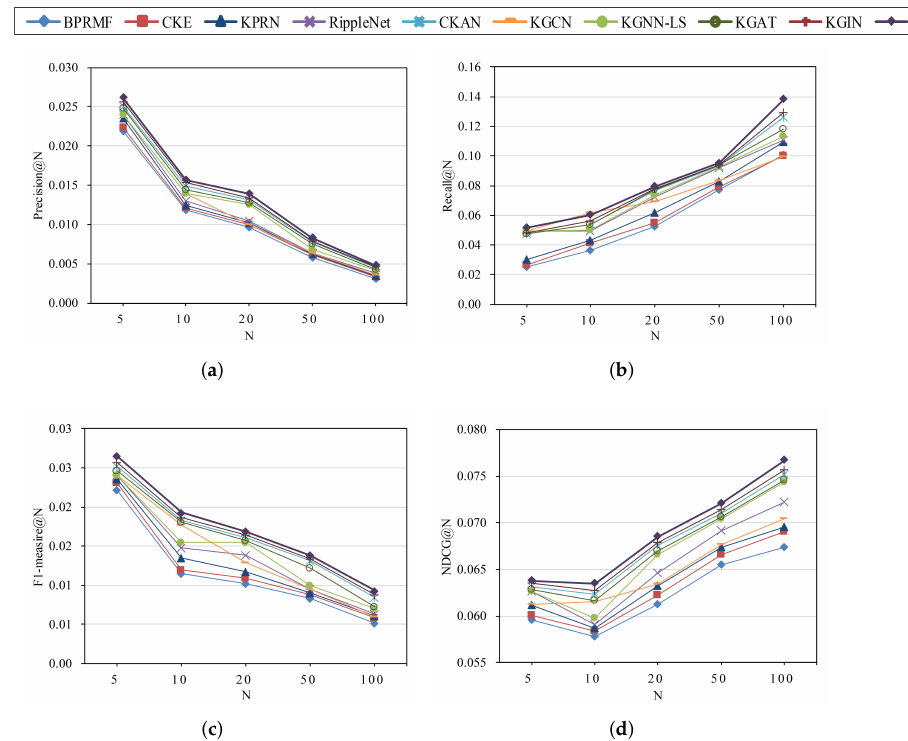
Figure 4. Top-N recommendation performance comparison on the Book-Crossing dataset. ( a ) Prece- sion@N; ( b ) Recall@N; ( c ) F1-measure@N; ( d )